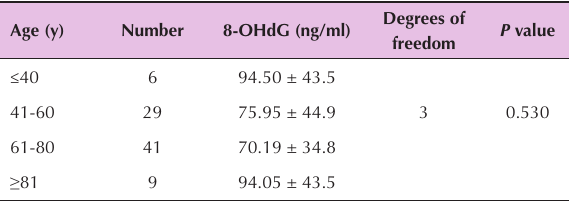
Table 6. Comparison of 8-OHdG serum levels in different age groups